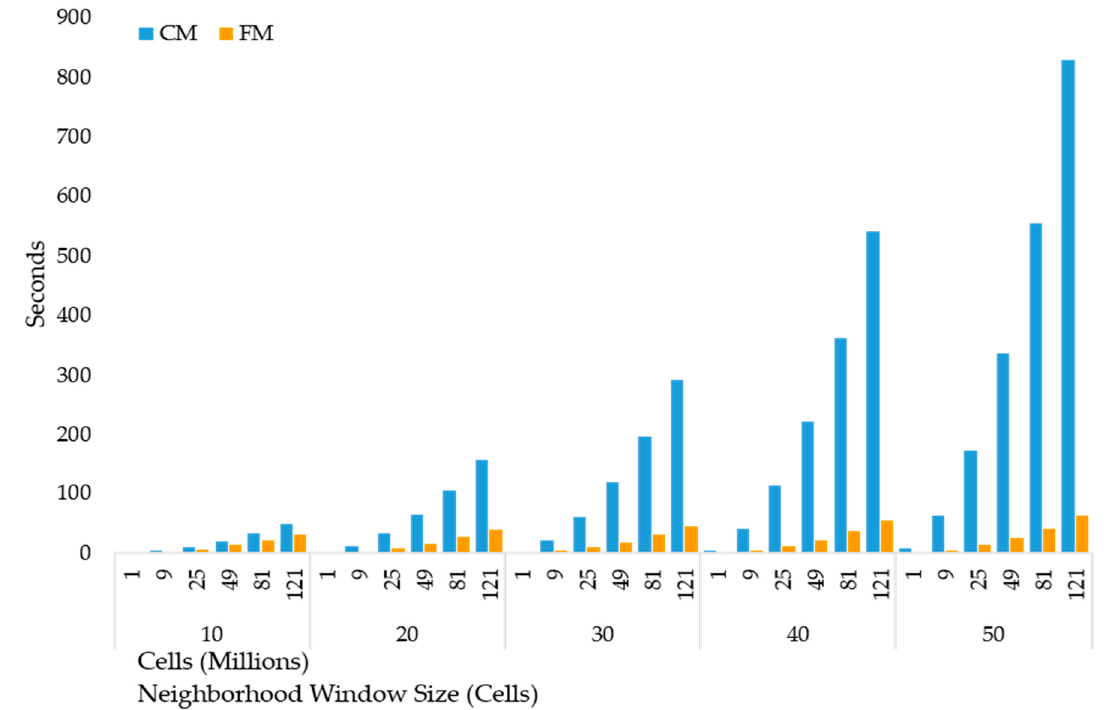
Figure 7. Conventional modeling (CM) and function modeling (FM) processing time for a focal mean procedure performed on images of varying sizes (cells) using five different neighborhood window sizes.